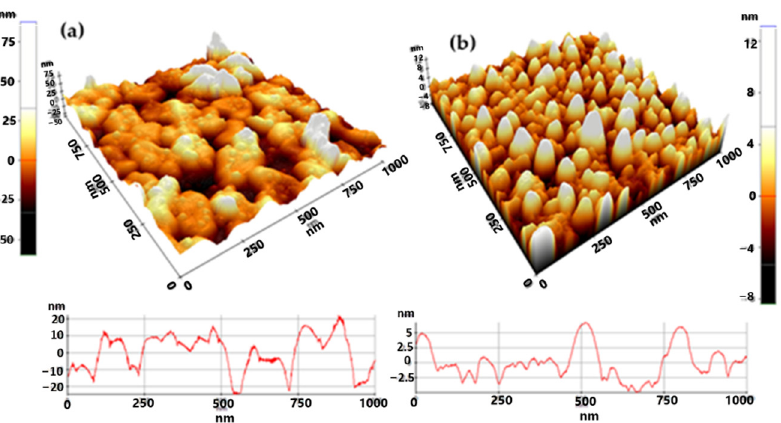
Figure 5. AFM topography and the horizontal line profile: ( a , b ) 3D topography images and corre- sponding line profile of MoS 2 and WS 2 samples, respectively. T able 1. AFM roughness parameters of MoS 2 and WS 2 samples.